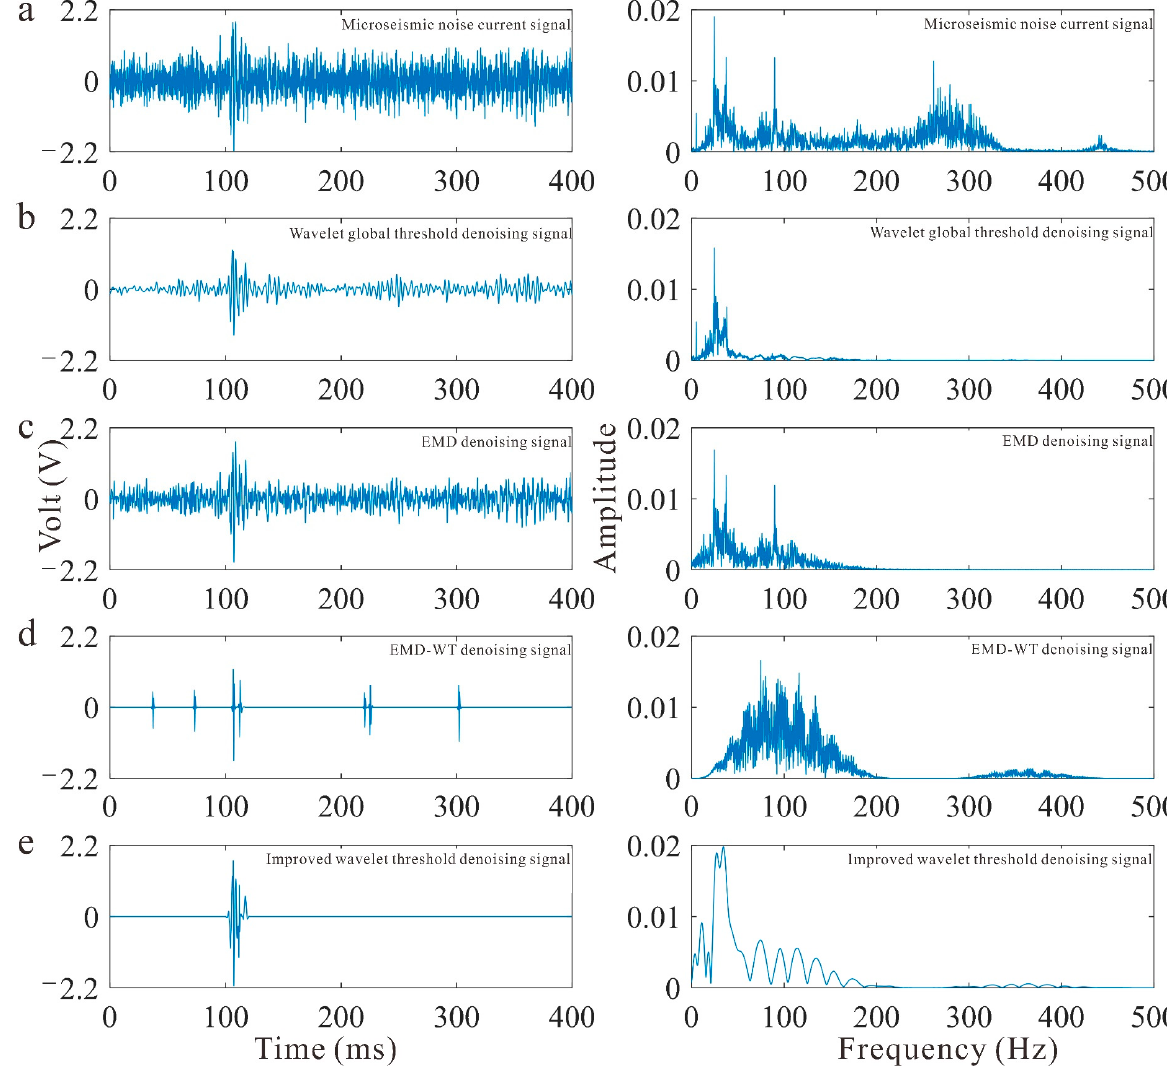
Denoising Table 4. The SNR MSE and r values after denoising based on an actual microseismic signal.